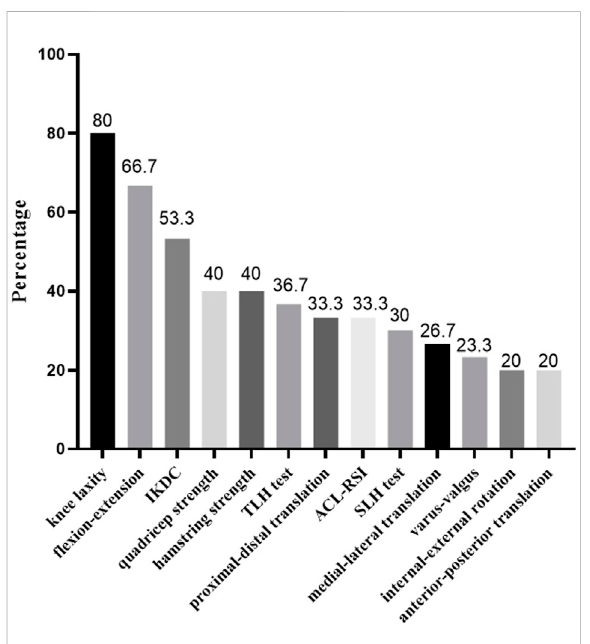
FIGURE 2 Percentages of participants ful fi lling the tests criteria, ranked from high to low.